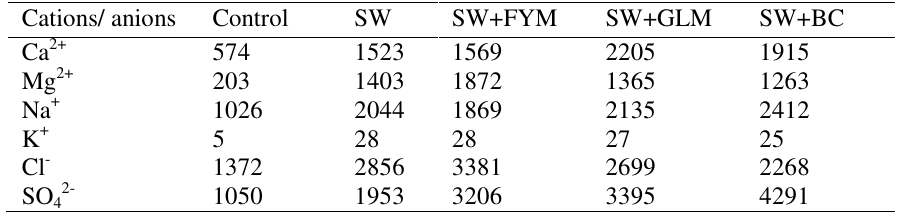
Table 4. Effect of spentwash and organic amendments on total amount (mg) of cations and anions leached from sodic soil.